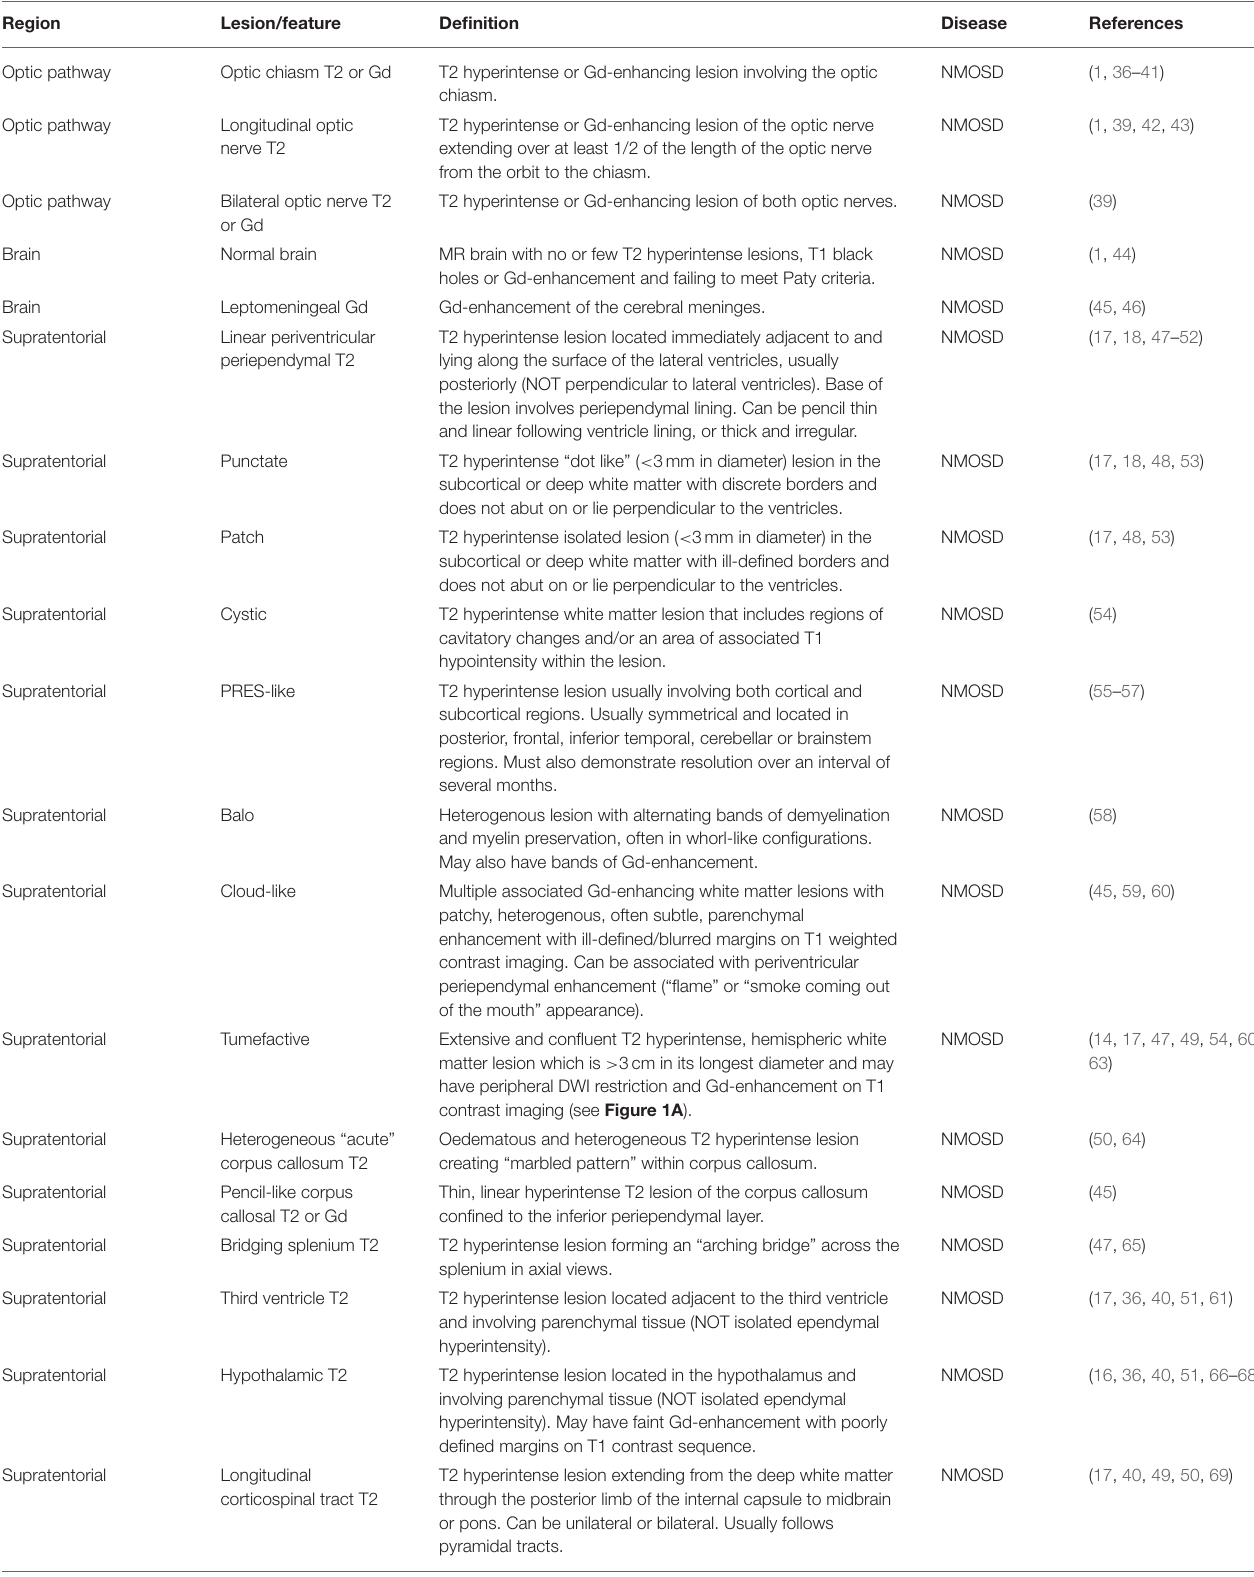
TABLE 1 | Identified MRI lesions and features with definitions and potential disease